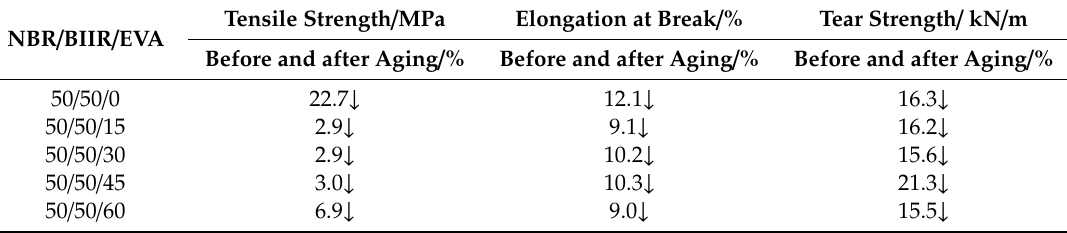
Figure 16. Comparison of mechanical properties before and after aging of NBR/BIIR/EVA with various blend ratios: ( a ) Tensile strength; ( b ) elongation at break, and ( c ) tear strength. Table 7. Mechanical property parameters before and after aging of NBR/BIIR/EVA with various blend ratios. Tensile Strength / MPa Elongation at Break / % Tear Strength / kN / m NBR / BIIR / EVA Before and after Aging / % Before and after Aging / % Before and after Aging / %